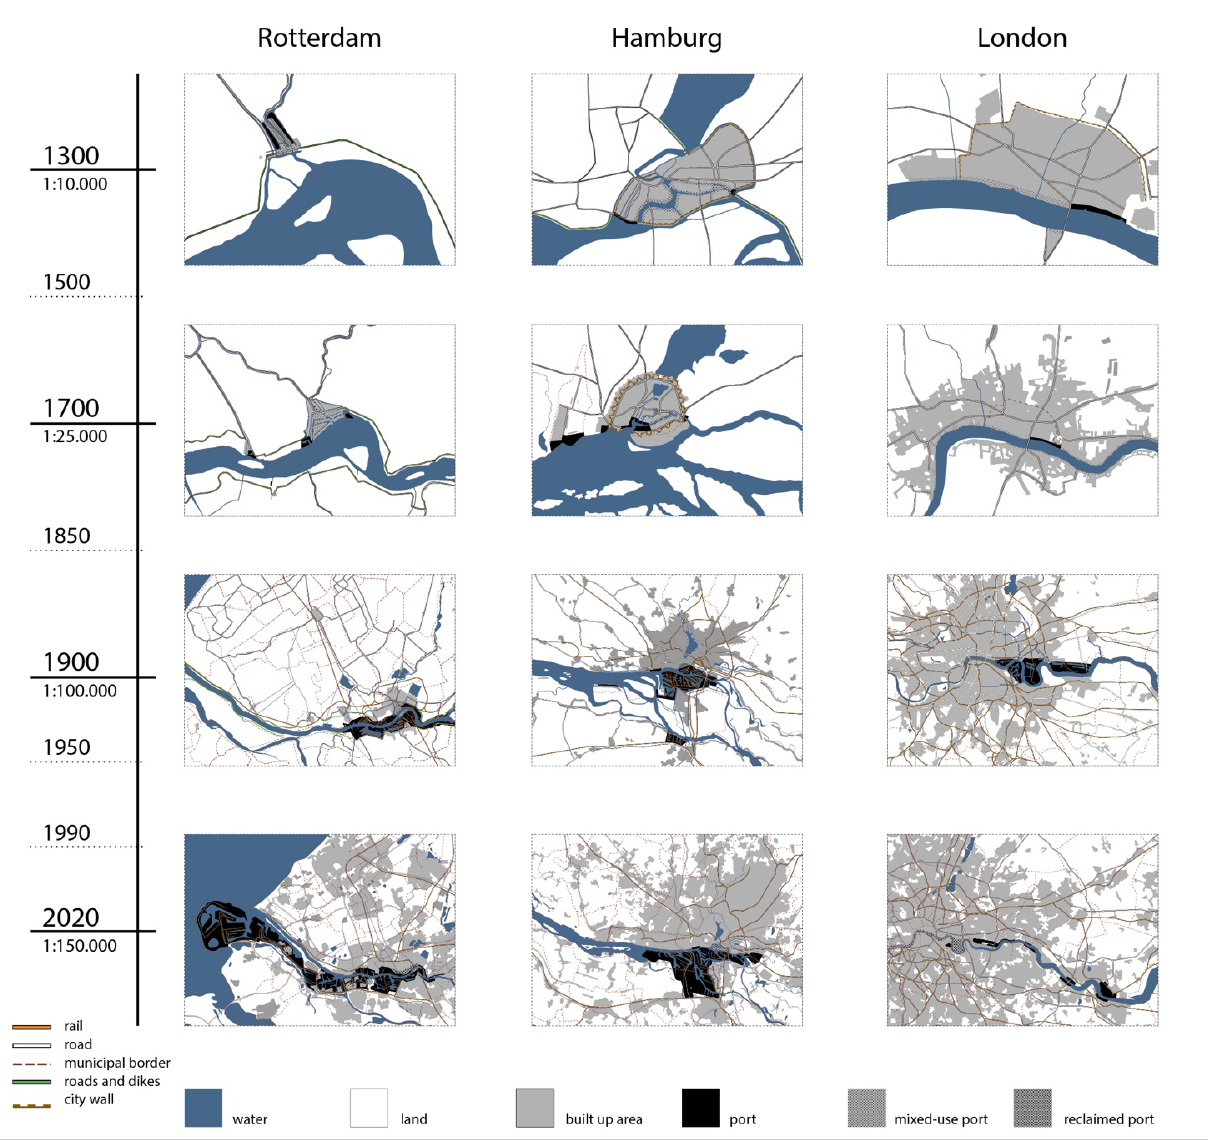
Figure 7. First draft for comparative geo-spatial mapping methodology, with case study of London, Hamburg, and Rotterdam. Figure by Carola Hein, Yvonne van Mil, Blanka Borbely, and Batuhan Özaltun based on Global Administrative Boundaries (2018) CORINE Land Cover (2016) and EuroGlobalMap